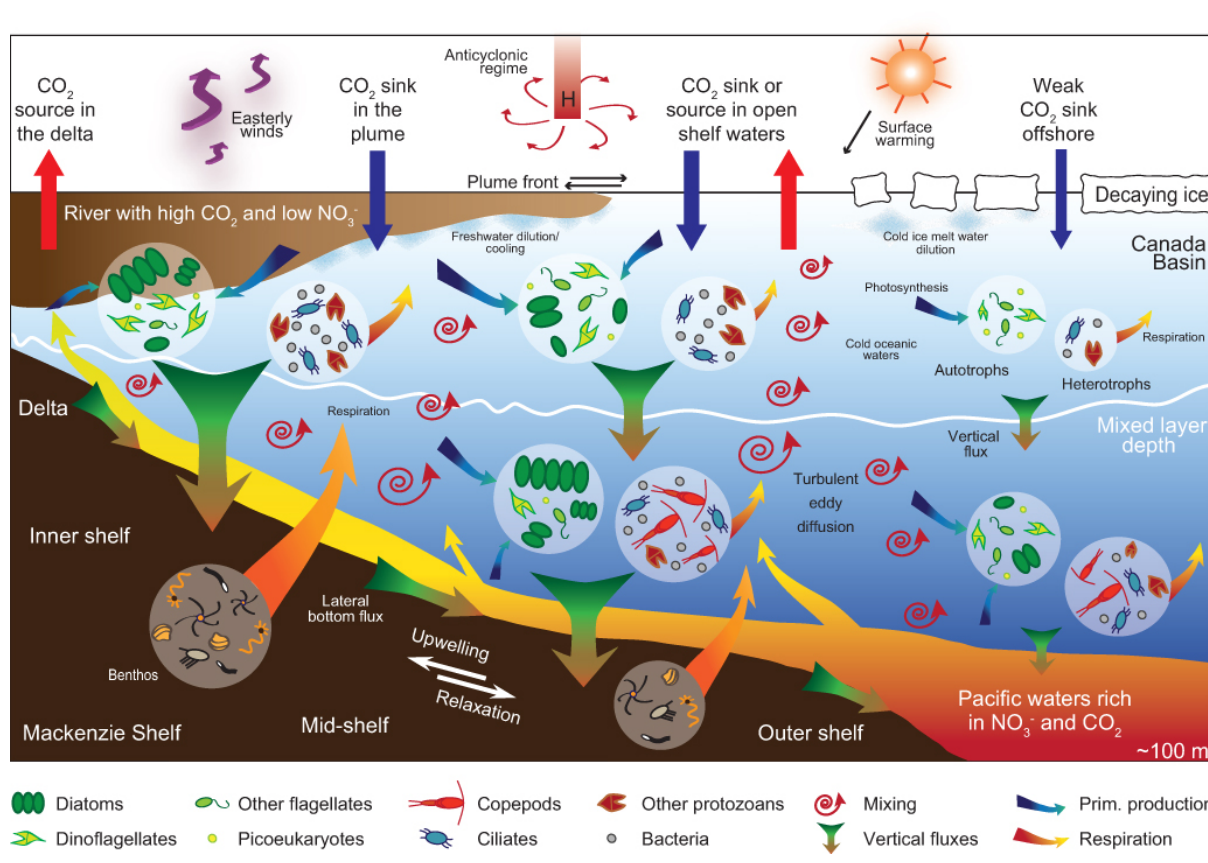
Figure 13. Schematics of food web structure and environmental forcings that synergistically drive ecosystem metabolic balance and sea-to- air CO 2 fluxes along the shelf–basin gradient in the changing Beaufort Sea. A succinct legend is presented below the schematics, but see Sect. 5 for detailed